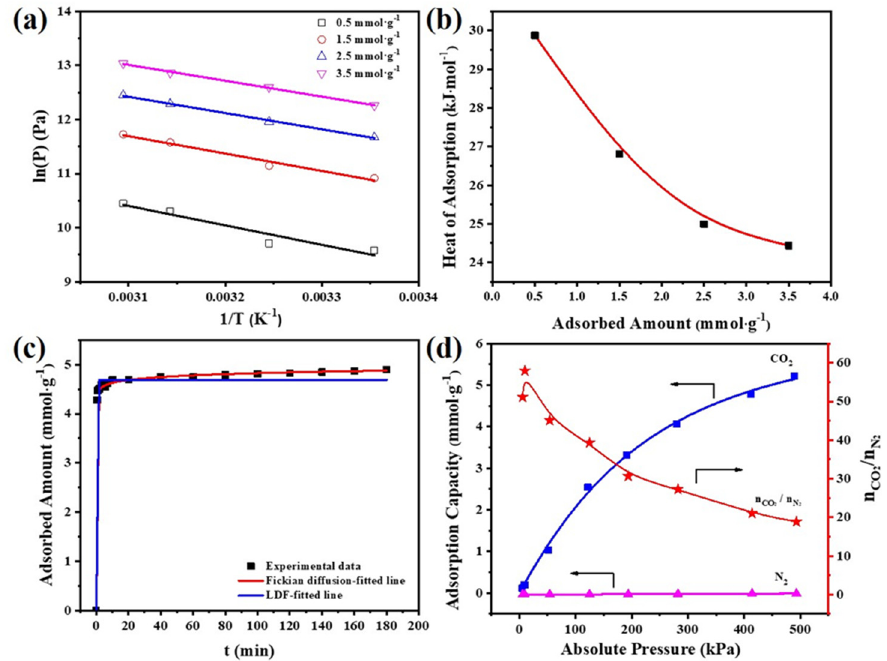
Figure 7. ( a ) Curves of ln(P) versus (1/T), ( b ) isosteric heat of adsorption at different CO 2 adsorption capacities, ( c ) CO 2 adsorption kinetics and ( d ) adsorption isotherms of N 2 and CO 2 at 298.15 K for GO(0.25)/MR-500.